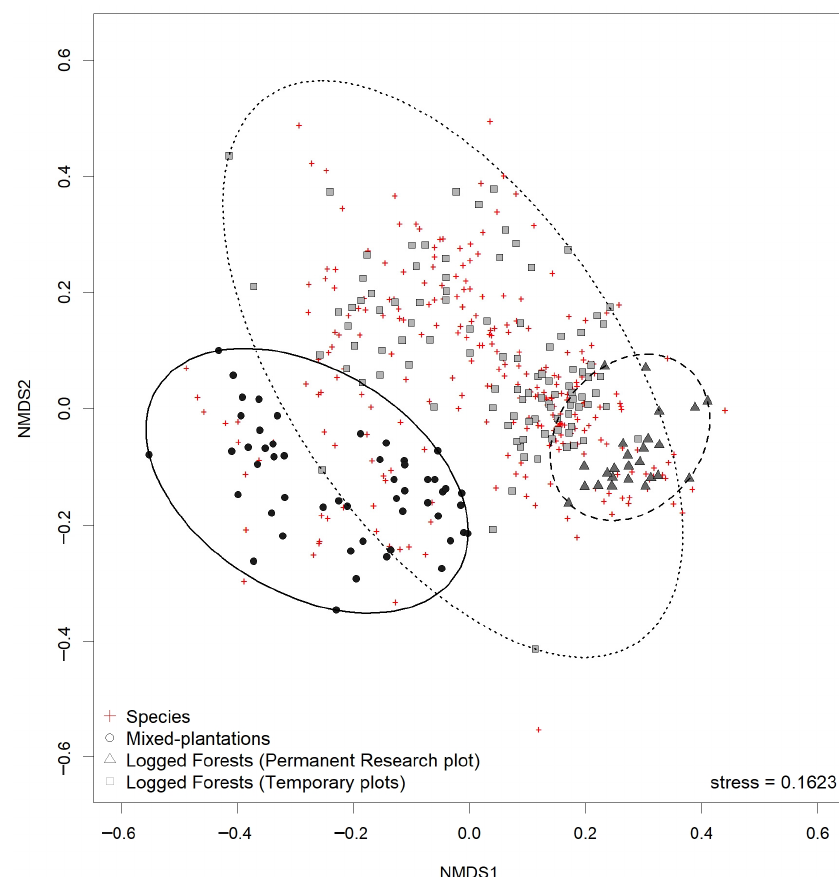
Figure 4. NMDS plot using Jaccard’s index of tree species from the three study sites.